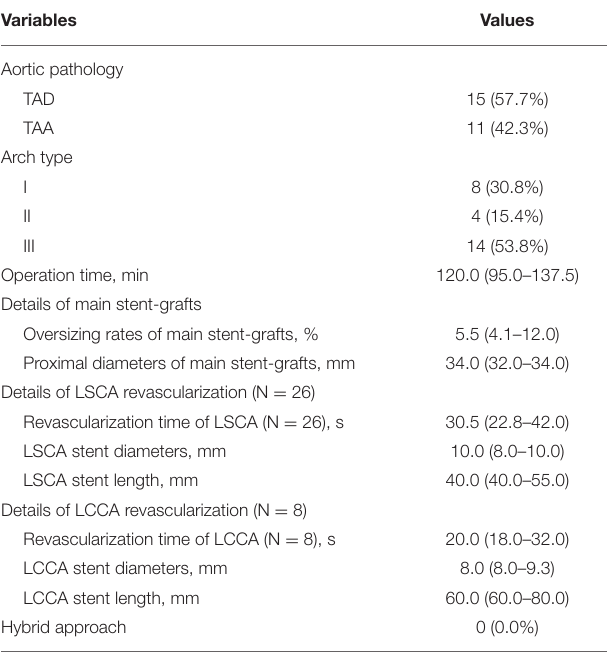
TABLE 2 | Endovascular procedure details of patients receiving the MCPF technique.